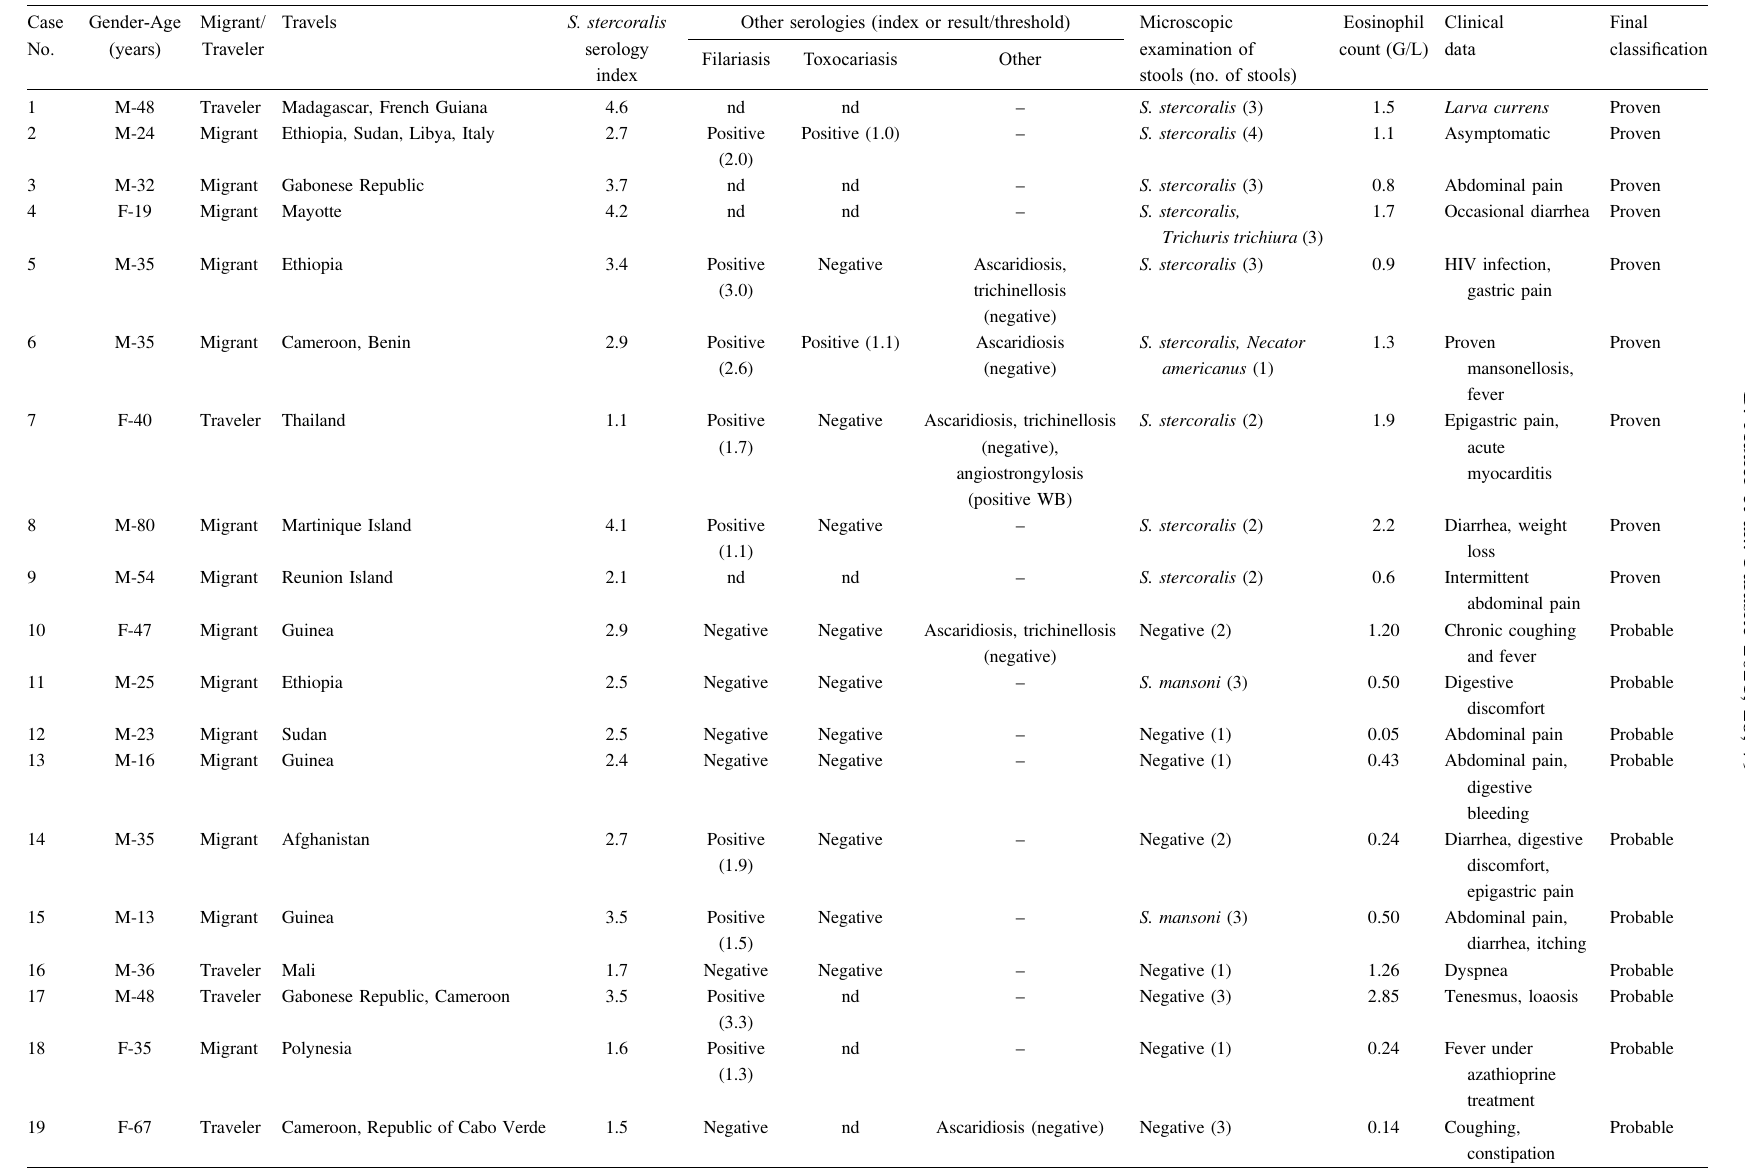
Table 5. Detailed characteristics of patients with positive